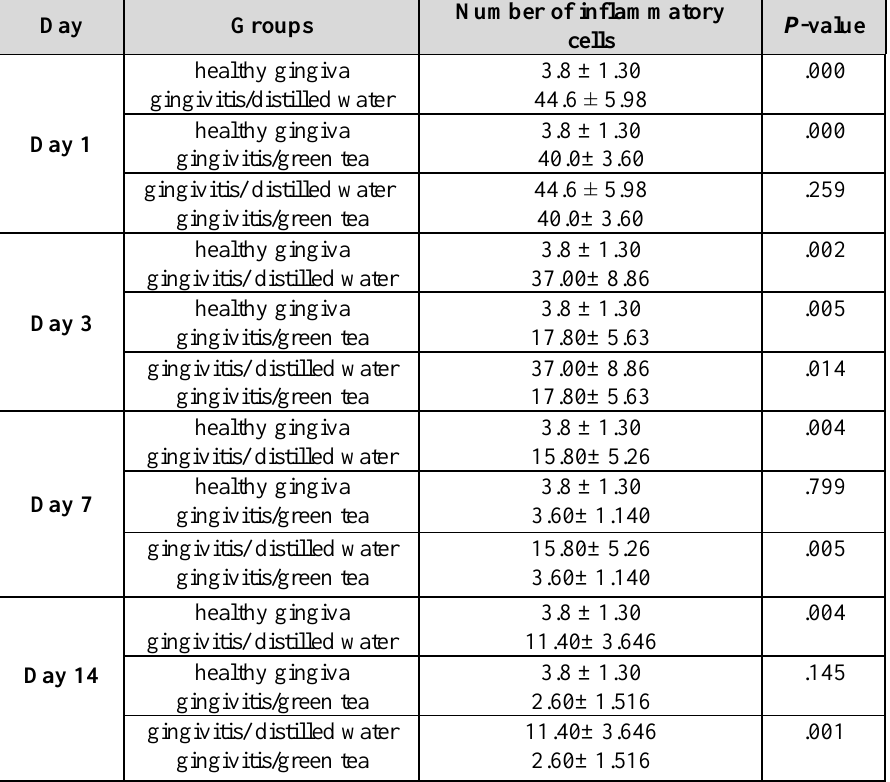
Table 1: Distribution of the observed inflammatory cells in different periods among the control group (healthy gingiva) and study groups irrigated with (distilled water and green tea